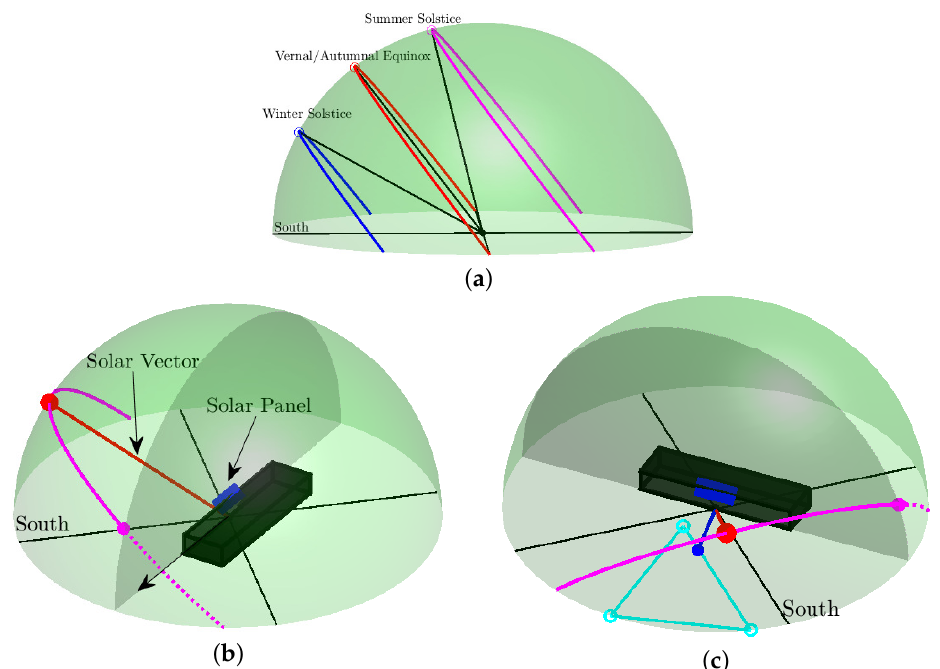
Figure 4. ( a ) Illustration of the trajectory of the sun when the positions of Earth are on solstice and equinox in Seoul. Note that these three traces have an identical normal vector. ( b ) Illustration of a trace of the sun (magenta) and possibly generating trajectory (solid line). Note that the dotted line is part of the trace where the sunlight does not shine due to the azimuth angle of buildings. Solar vector (red) and solar panel (blue) are represented with the shaded region, which represents a possible area to receive sunlight. The black cuboid is a schematic illustration of the residence; it is actually treated as a point (the origin) in our method. ( c ) Illustration of the solar vector (red) and the best-fitted normal vector (blue). Note that a cyan-colored triangle represents the boundary of all possibly taken normal vectors of the solar